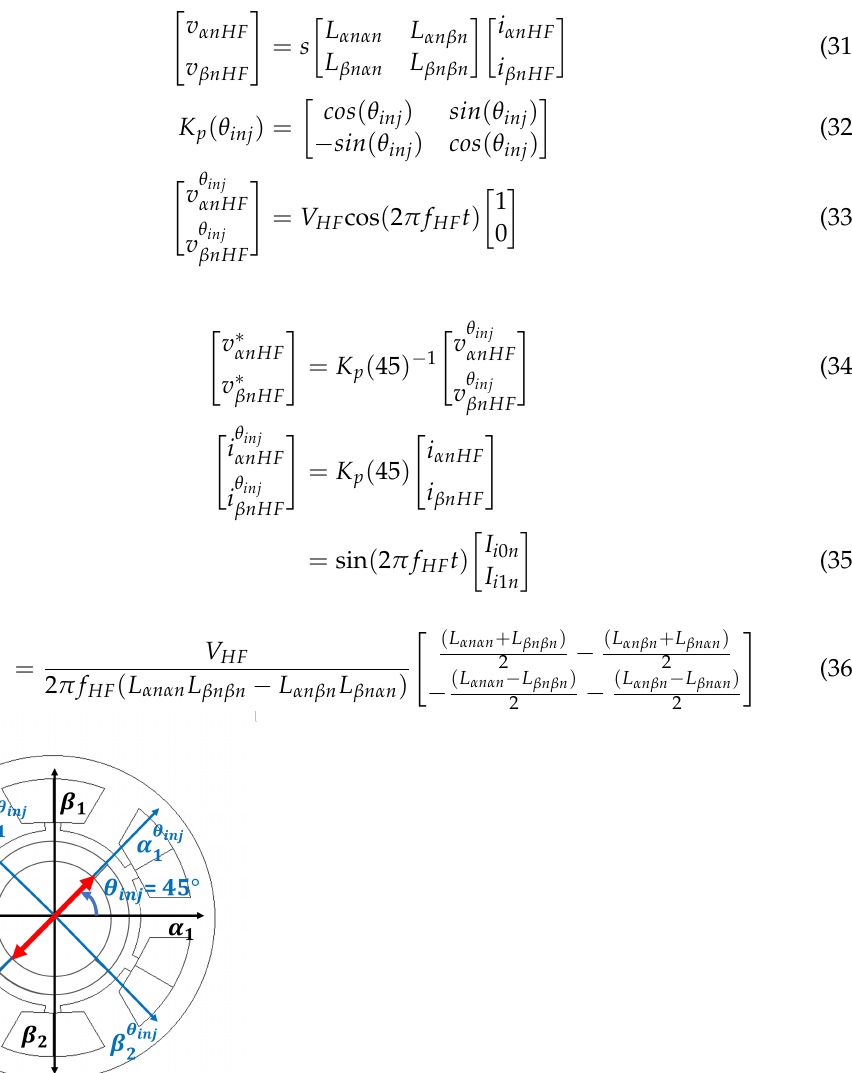
Figure 8. HF pulsating voltage injection reference frame, αβ reference frame, αβ 1 and αβ 2